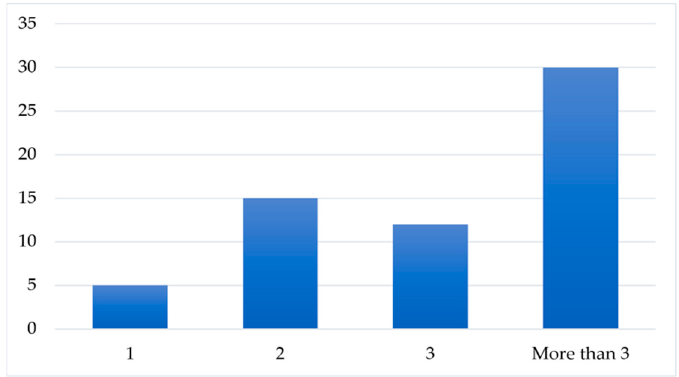
Figure 6. Frequency of articles based on the number of authors in each publication.